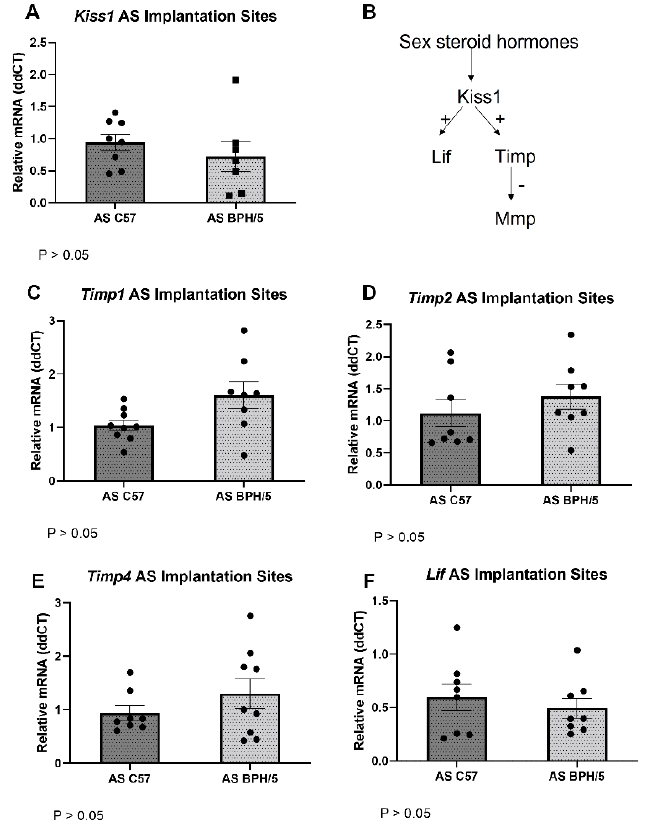
Figure 5. Artificial synchronization of sex steroid hormones (AS-SSH) during early gestation in the BPH/5 mouse normalizes the expression of Kiss1 and downstream molecules. ( A ) Relative gene expression quantification of Kiss1 . ( B ) Proposed upstream and downstream pathways of uteroplacental kisspeptin signaling. Relative gene expression quantification of the Kiss1 downstream molecules ( C ) Timp-1 , ( D ) -2 , ( E ) -4 and ( F ) Lif in the embryonic implantation sites of AS-SSH BPH/5 females vs. AS-SSH C57 females measured via qRT-PCR ( n = 8–9/group). Student’s t -test, * p < 0.05 vs. time-matched C57. Data expressed as mean ±